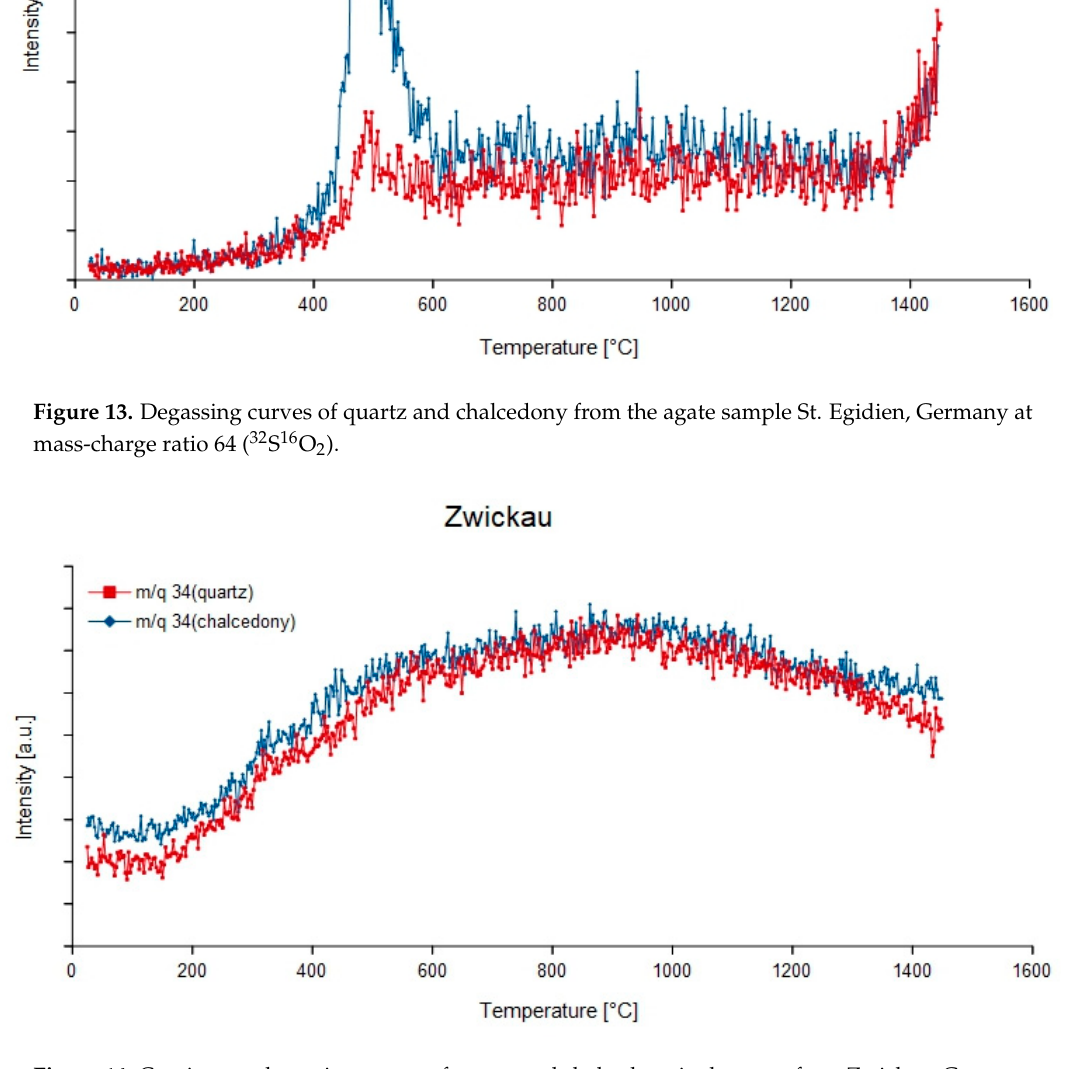
Figure 14. Continuous degassing curves of quartz and chalcedony in the agate from Zwickau, Germany at mass-charge ratio 34 ( 1 H 232 S).